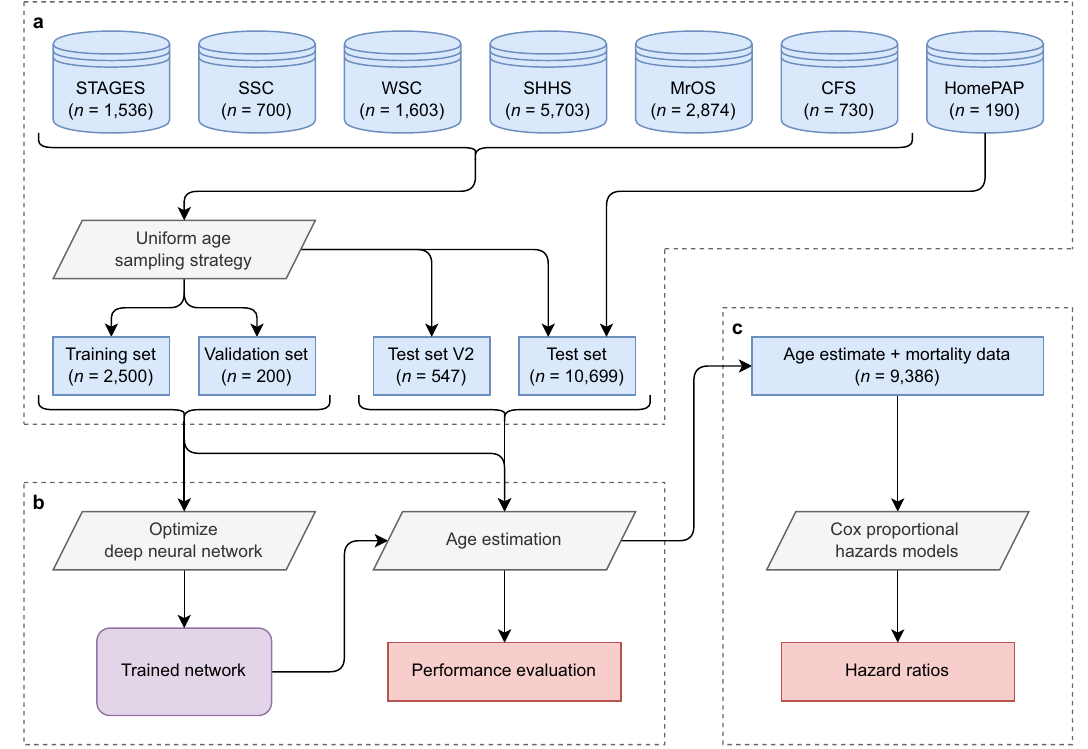
Fig. 5 Use of data for age estimation and evaluating mortality risk. a The data from six cohorts are sampled to generate a training and validation set with a uniform age distribution. The remaining data comprises a test set, some of which has additional visits (test set V2). b Age estimation models are optimized and evaluated in all data. c Associations between increased age estimate errors and mortality risk are evaluated in all available data using Cox proportional hazards